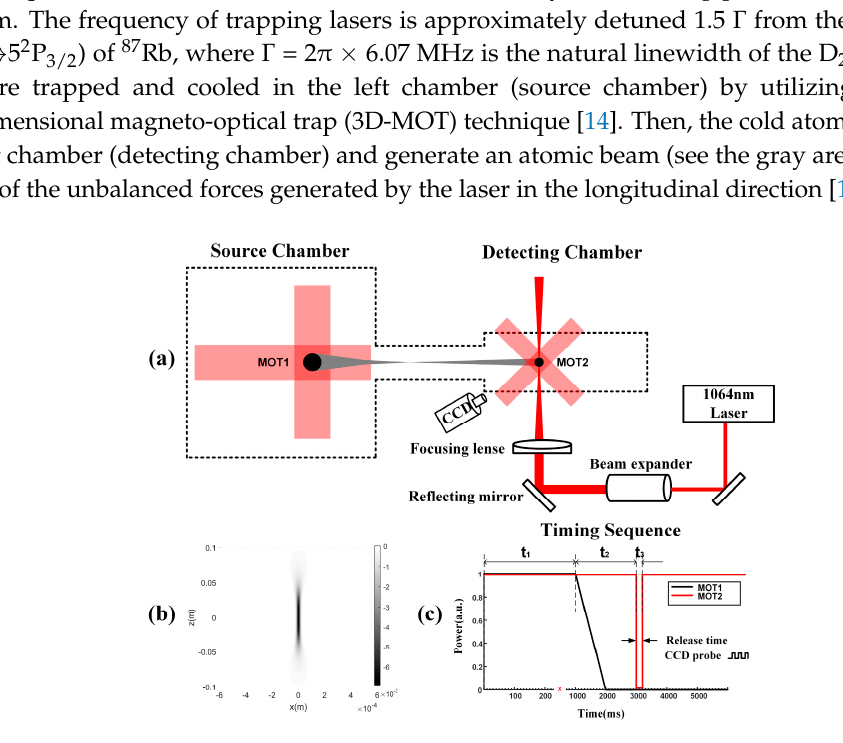
Figure 1. ( a ) Schematic of the experimental setup. ( b ) Simulation diagram of the dipole potential of the guiding laser. ( c ) Timing sequence of experimental procedures in two chambers. guiding laser. ( c ) Timing sequence of experimental procedures in two